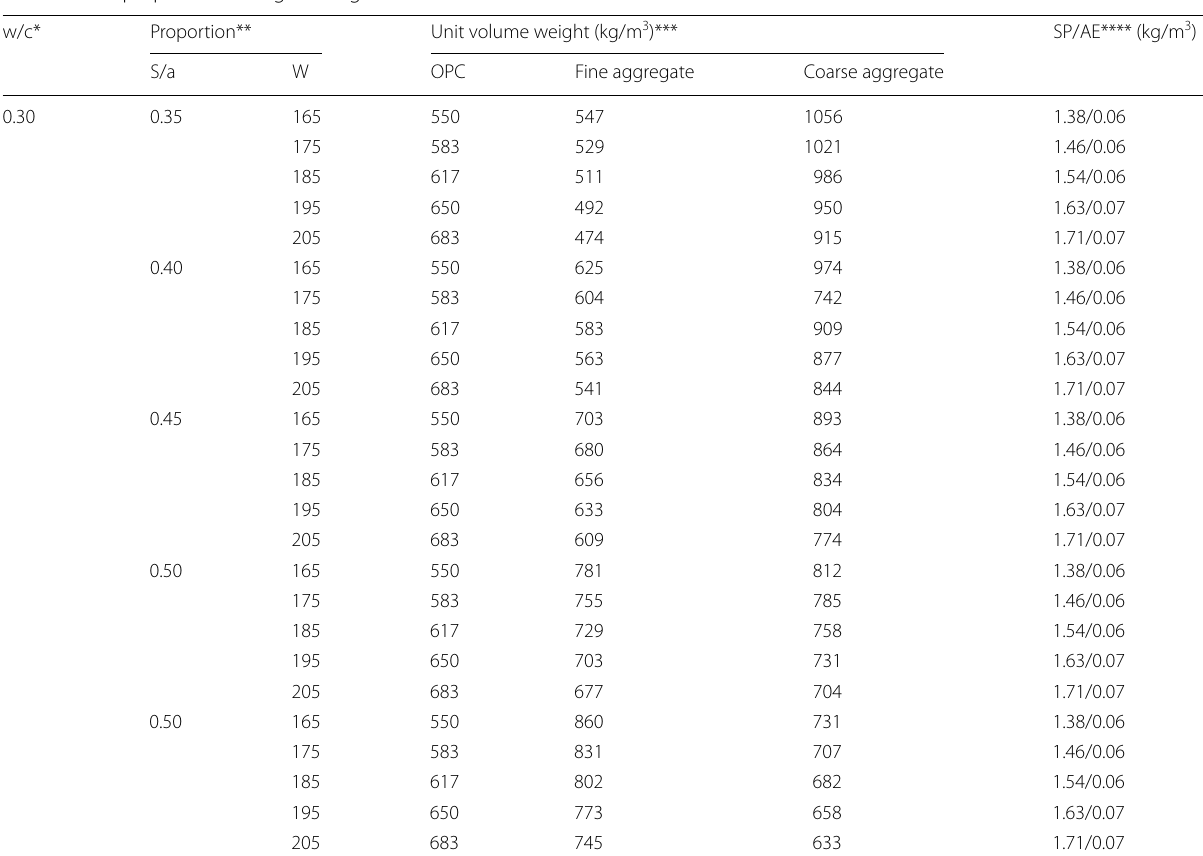
Table 3 Mix proportions of high‑strength concrete